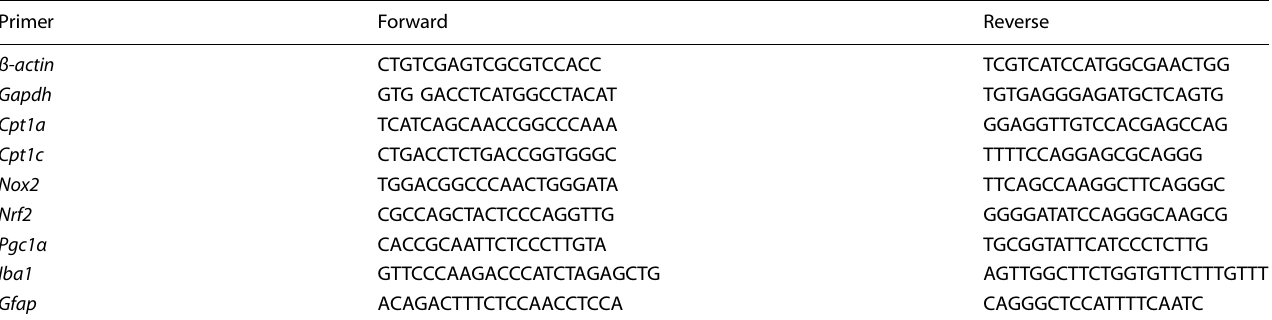
Table 1. Primer sequences for primers from